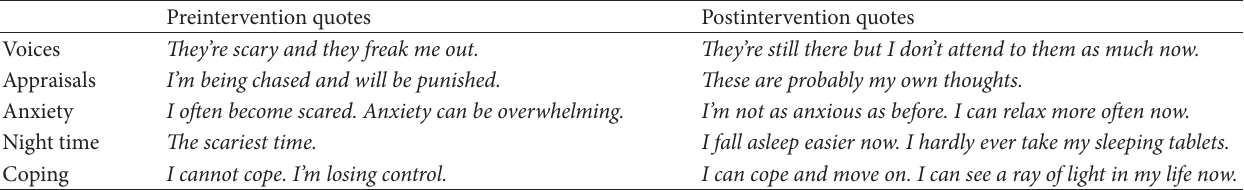
Table 1: Subjective pre- and postintervention reflections on the patient’s own difficulties.